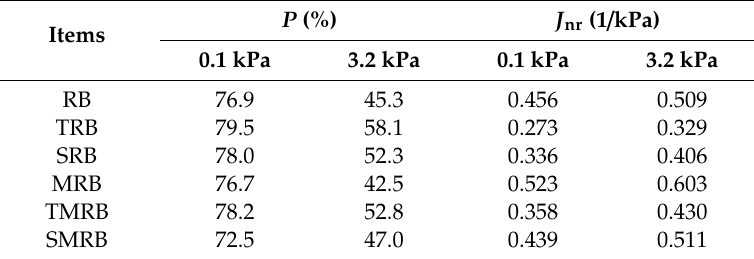
Table 3. J nr and P obtained from the MSCR test.